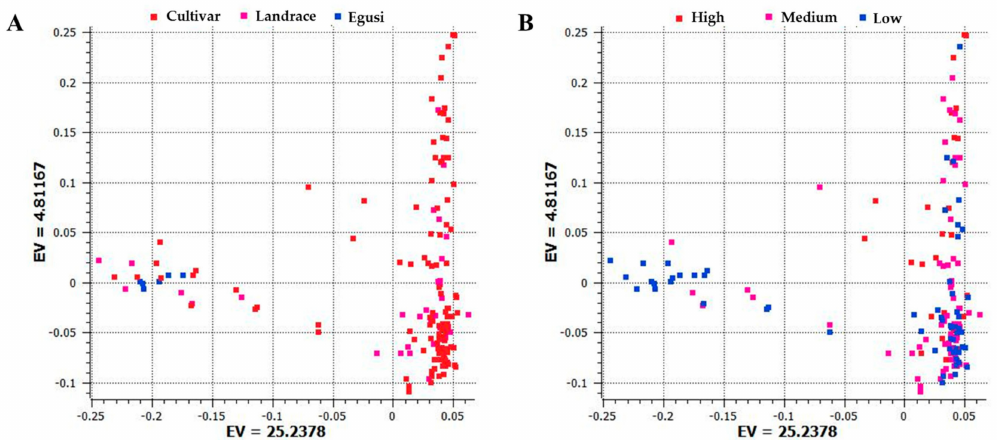
Figure 2. Principal component analysis (PCA) based on the first two components showing the distribution of ( A ) cultivars, landraces, and egusi types; ( B ) and low, medium, and high citrulline content in 187 watermelon accessions by using 1410 single nucleotide polymorphisms (SNPs) generated by genotyping by sequencing. Each dot represents an accession. EV indicates the percentage of explained variance.